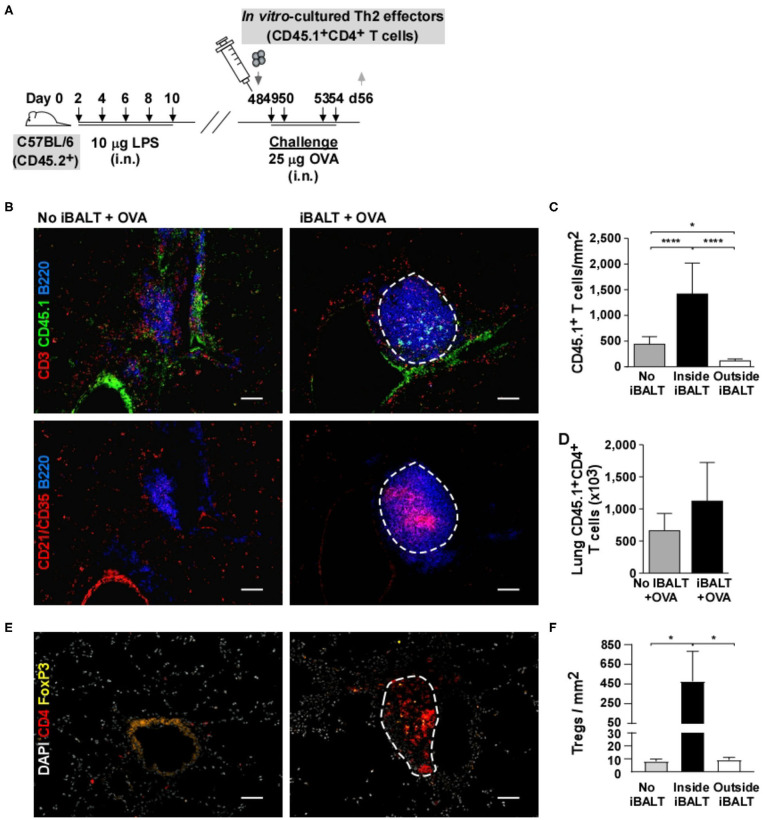
The presence of iBALT alters the spatial distribution of T cells. (A) Timing of iBALT induction, effector Th2 transfer and antigen challenge. (B) Serial cryosections were probed with antibodies against CD3, CD45.1 and B220 or with antibodies against CD21/CD35 and B220 as indicated. Images were obtained with 20X objective (scale bar = 100 μm). (C) The frequency of CD45.1+ T cells per μm2 was determined in areas of iBALT (an example is outlined in white) or in non–iBALT areas using a mosaic of high–magnification images. (D) The numbers of lung CD45.1+CD4+ T cells were determined by flow cytometry. (E) Cryosections were probed with antibodies against CD4 and FOXP3. Images were obtained with 20X objective (scale bar = 100 μm). (F) The frequency of CD45.1+ T cells per μm2 was determined in areas of iBALT (an example is outlined in white) or in non–iBALT areas using a mosaic of high–magnification images. All data show mean ± SD of 4–5 mice per group; *P < 0.05, ****P < 0.0001. Experiments were performed 3 times (A–D) or 1 time (E,F).